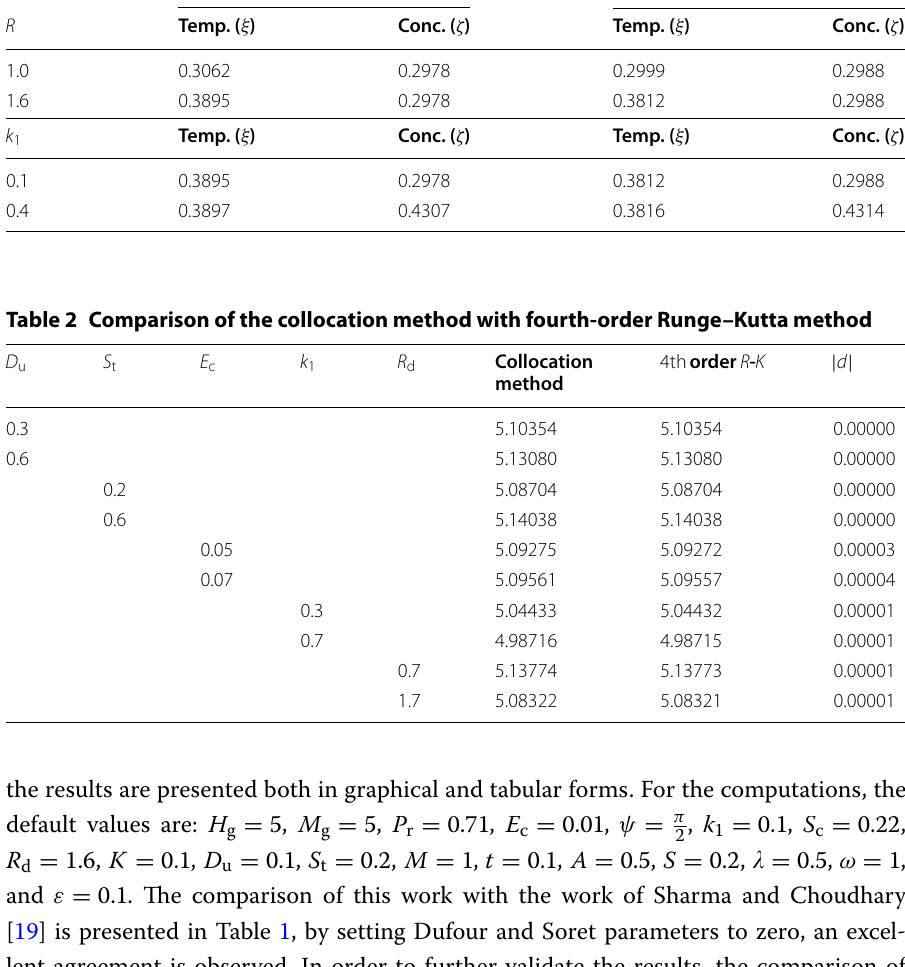
Table 1 Comparison of the present work with Sharma and Choudhary [19] Sharma and Choudhary Present work R Temp. ( ξ )